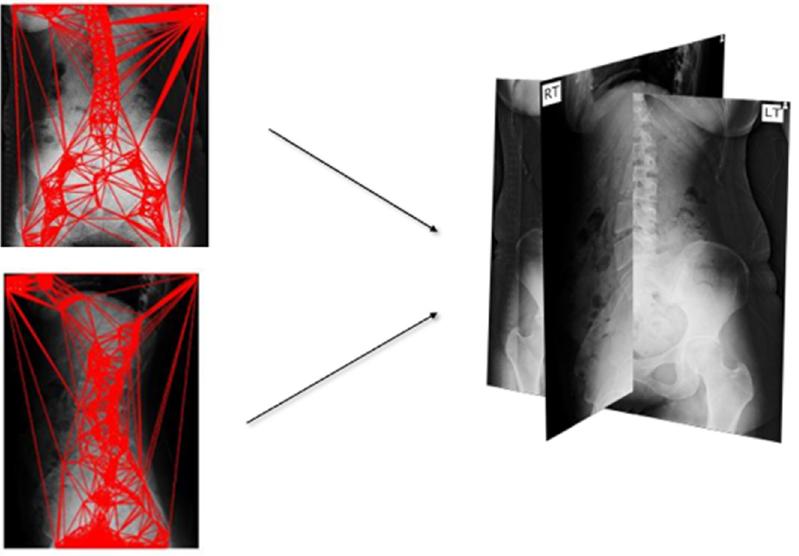
Figure 9. Triangulation of AP view ( left ) and LA view ( right ) .